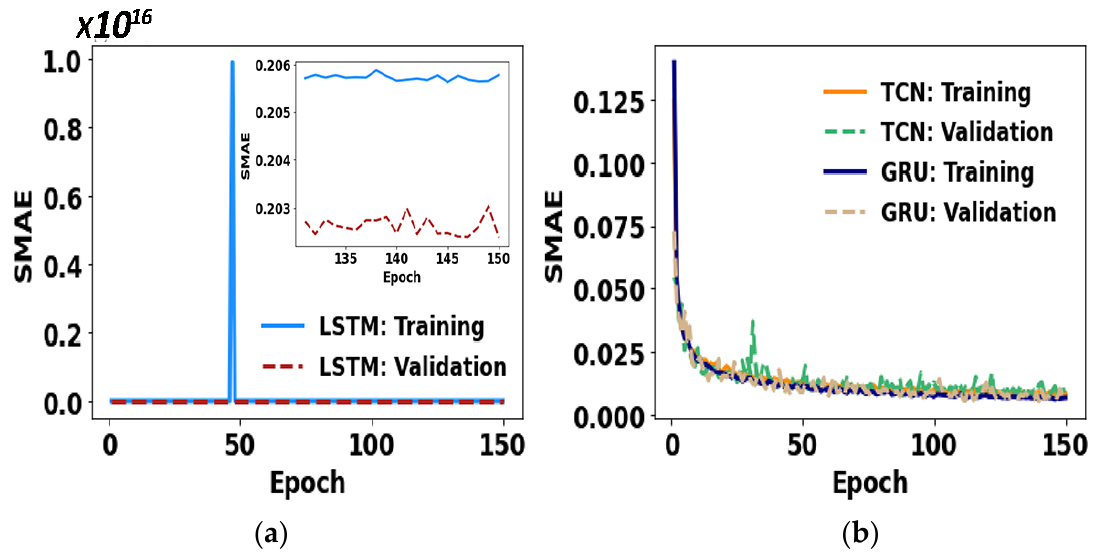
Figure 9. Convergence history: ( a ) LSTM and ( b ) GRU and TCN.